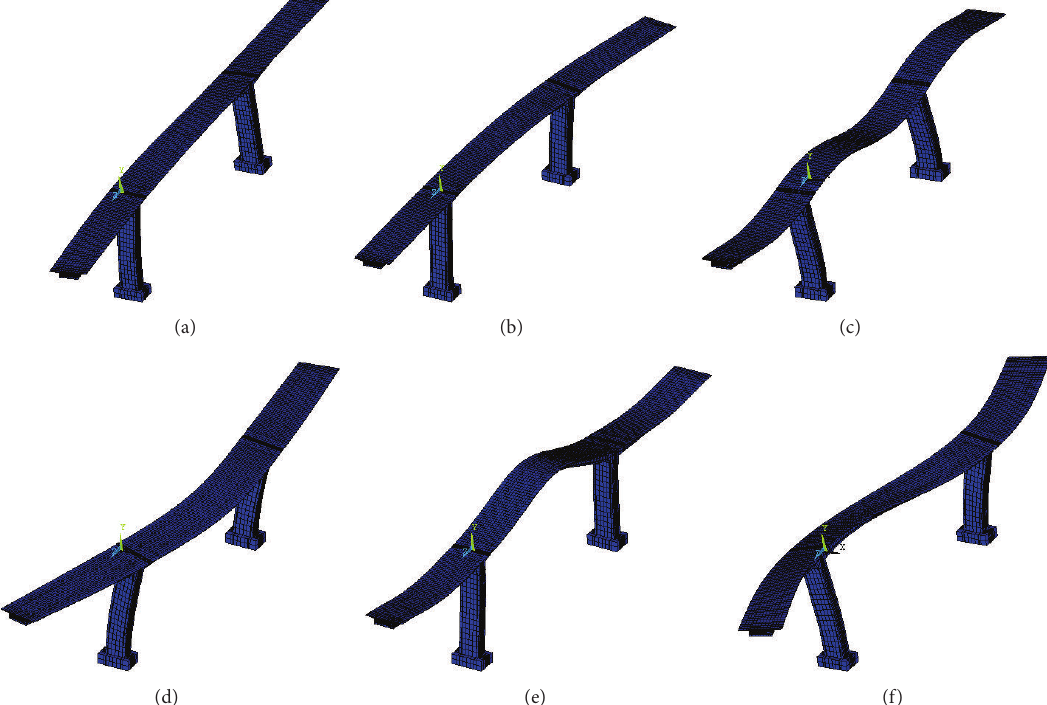
Figure 9: First six mode shapes of the continuous rigid-frame bridge: (a) first mode, (b) second mode, (c) third mode, (d) fourth mode, (e) fifth mode, and (f) sixth mode.